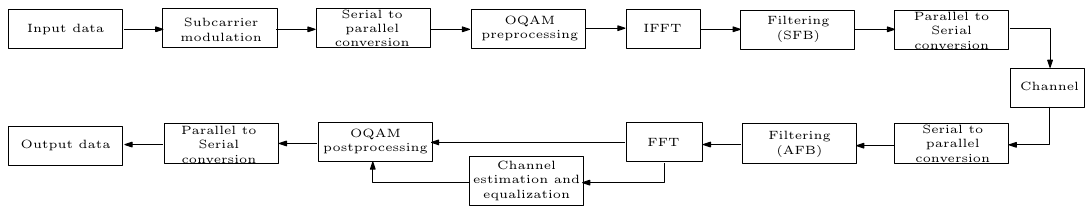
Figure 15. Structure of a filter bank OFDM-OQAM system.